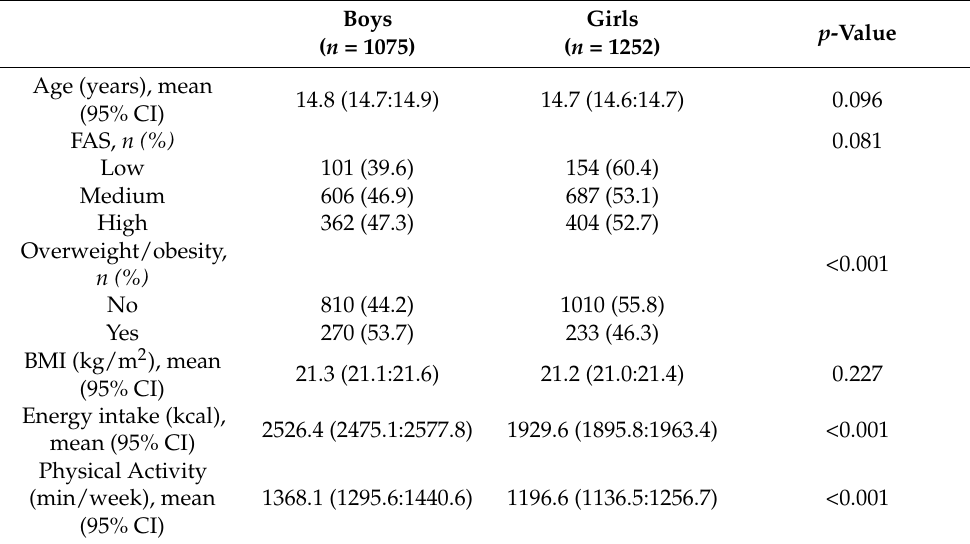
Table 1. Characteristics of the study population according to sex. HELENA